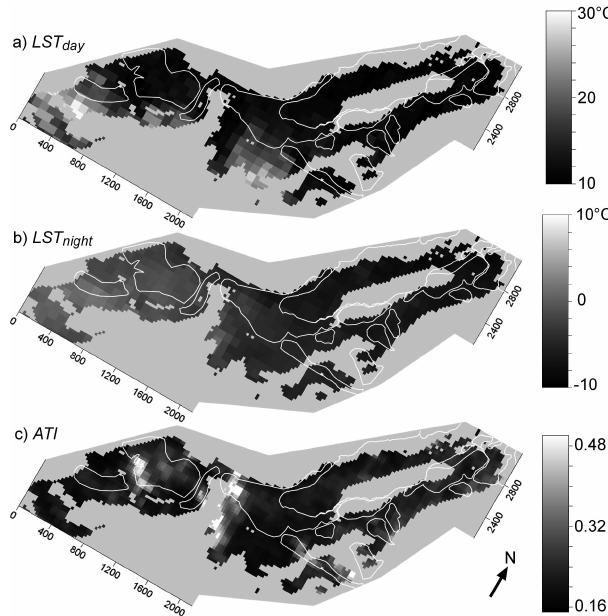
Fig. 2. Maps of (a) LST day , (b) LST night , (c) ATI in the Punta Negra valley. Grey background areas correspond to masked